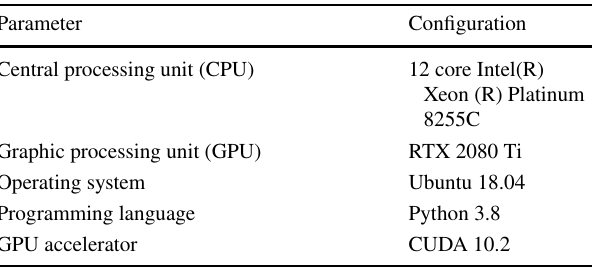
Table 2 Configuration of parameters Parameter Configuration